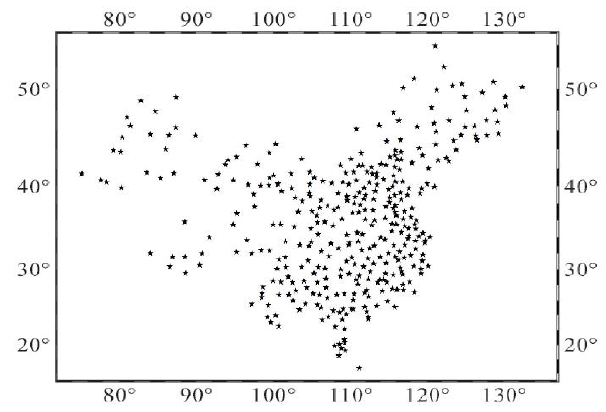
Figure 1. Flow chart of real-time tropospheric product